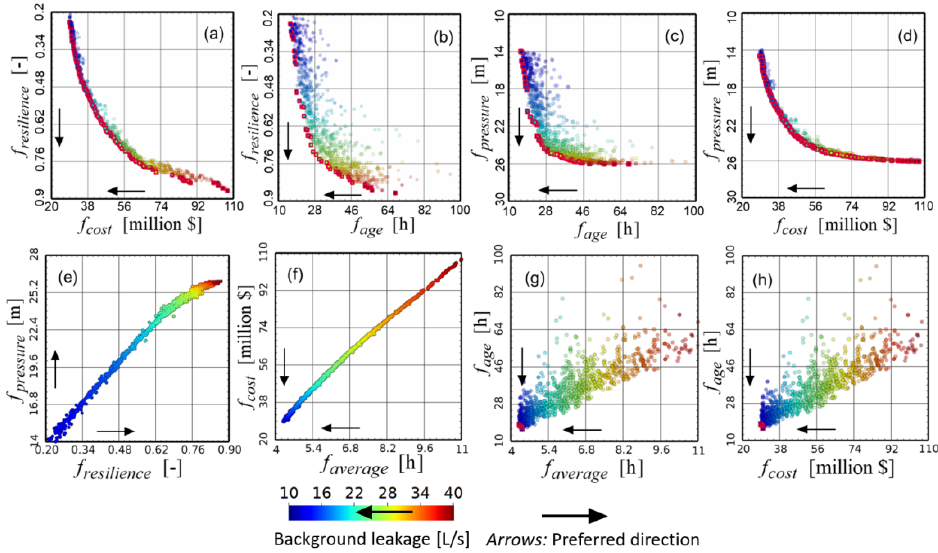
Figure 4. Selected two-objective subsets in the context of the full six-objective space: ( a ) f cost versus f resilience ; ( b ) f age versus f resilience ; ( c ) f age versus f pressure ; ( d ) f cost versus f pressure ; ( e ) f pressure versus f resilience ; ( f ) f cost versus f average ; ( g ) f age versus f resilience ; and ( h ) f age versus f cost .